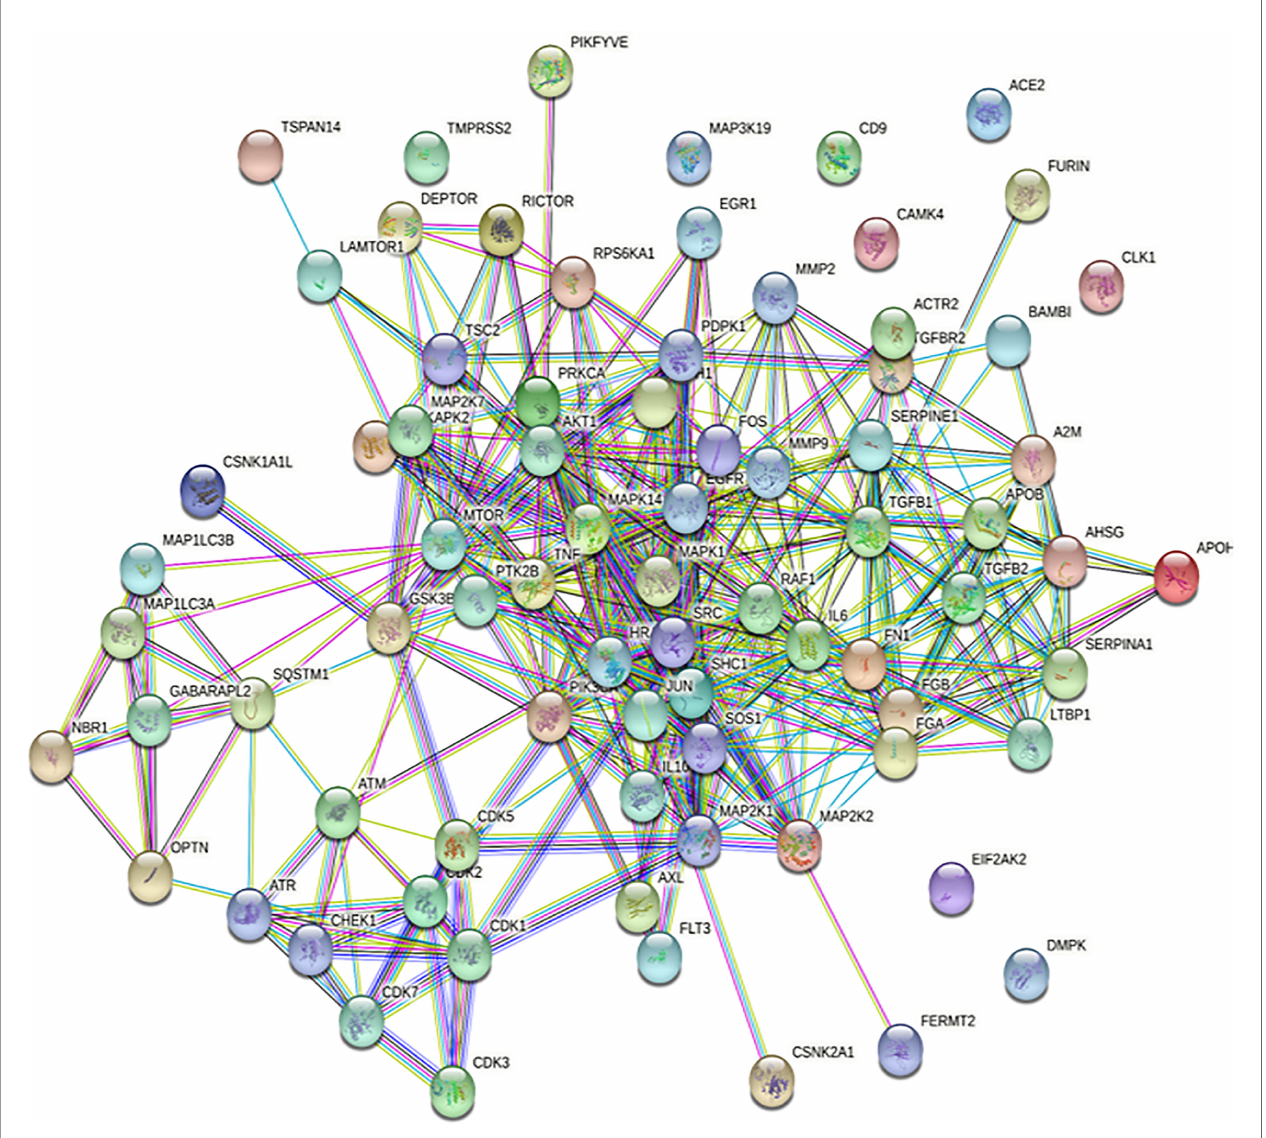
FIGURE 4 | Interaction network of major proteins involved in COVID-19 at high con fi dence